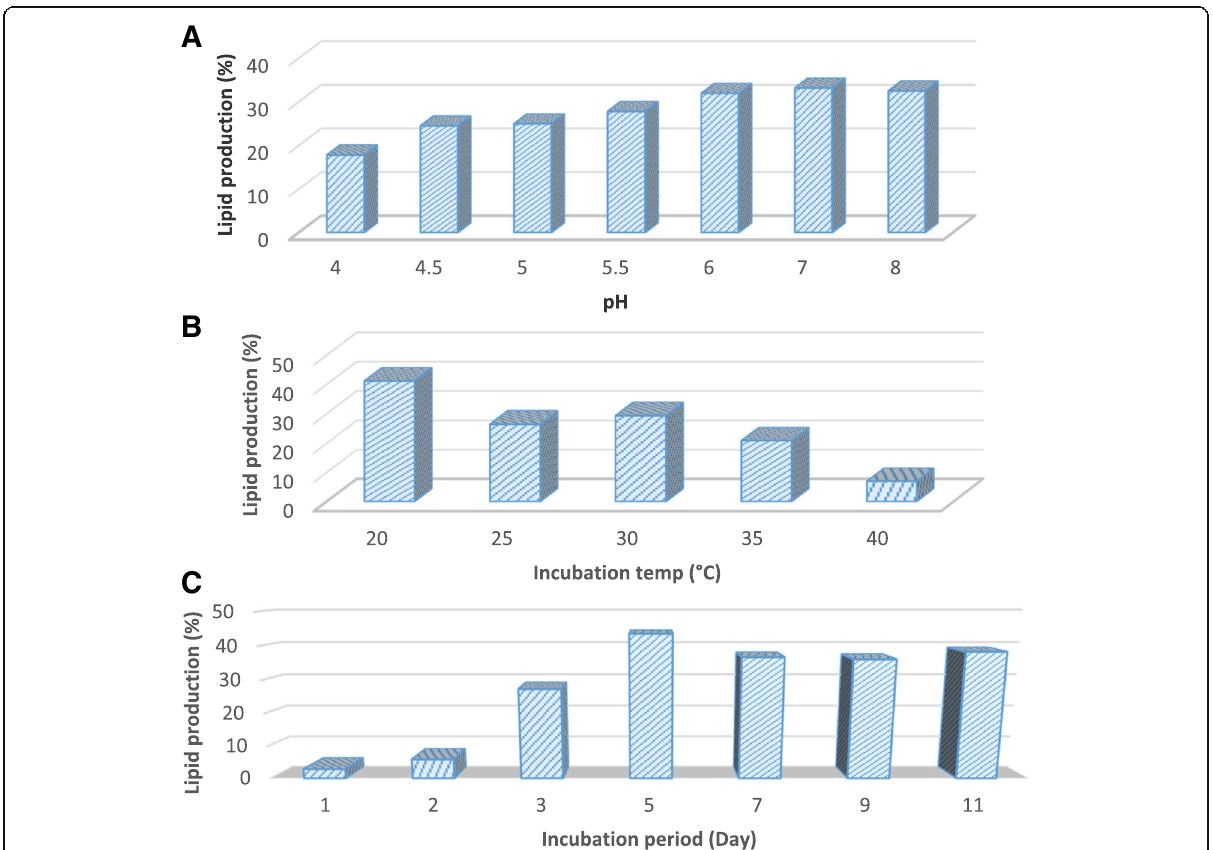
Fig. 1 Effect of initial pH ( a ), incubation temperatures ( b ), and incubation period ( c ) on P. commune NRC2016 lipid